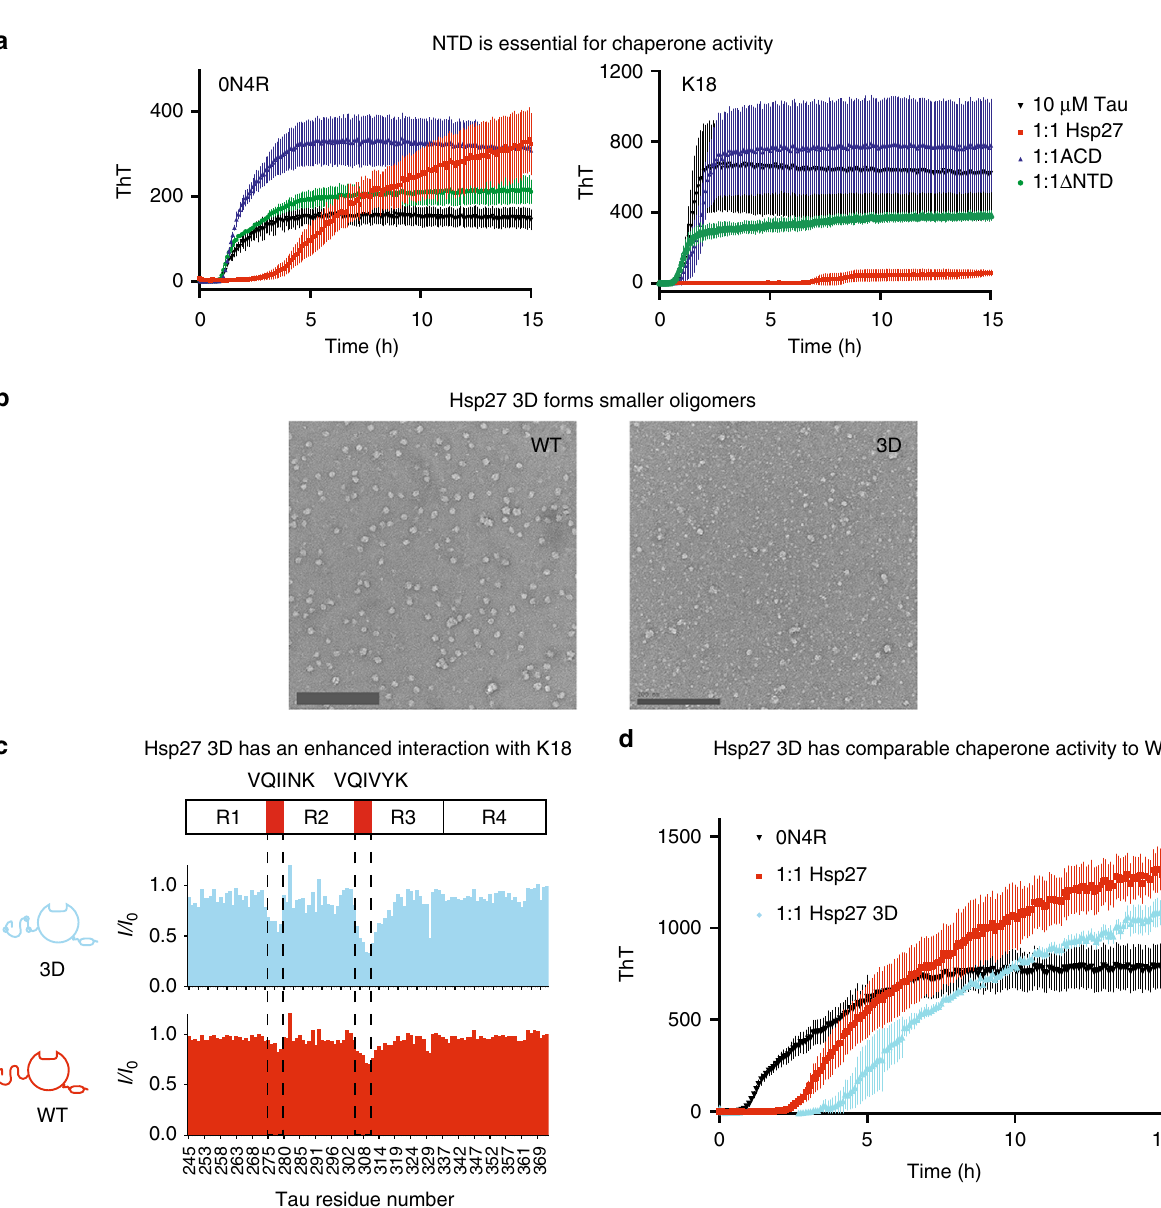
Fig. 3 Hsp27 ’ s NTD plays an important role in chaperoning tau. a Representative tau aggregation curves in the presence of truncated Hsp27 constructs. Aggregation of 0N4R (left) or K18 (right) in the presence of listed chaperones at a 1:1 molar ratio (10 μ M). Data points are the mean ± SEM of 3 technical replicates. RFU, relative fl uorescence units. b Left, Negative-stain EM images of WT (left) and 3D (right) Hsp27. Images are representative of a minimum of 12 random fi elds. Scale bar is 200 nm. Right, SEC-MALS trace of Hsp27 WT and 3D (40 μ M). c Intensity ratios of 50 μ M 15 N K18 in the presence of